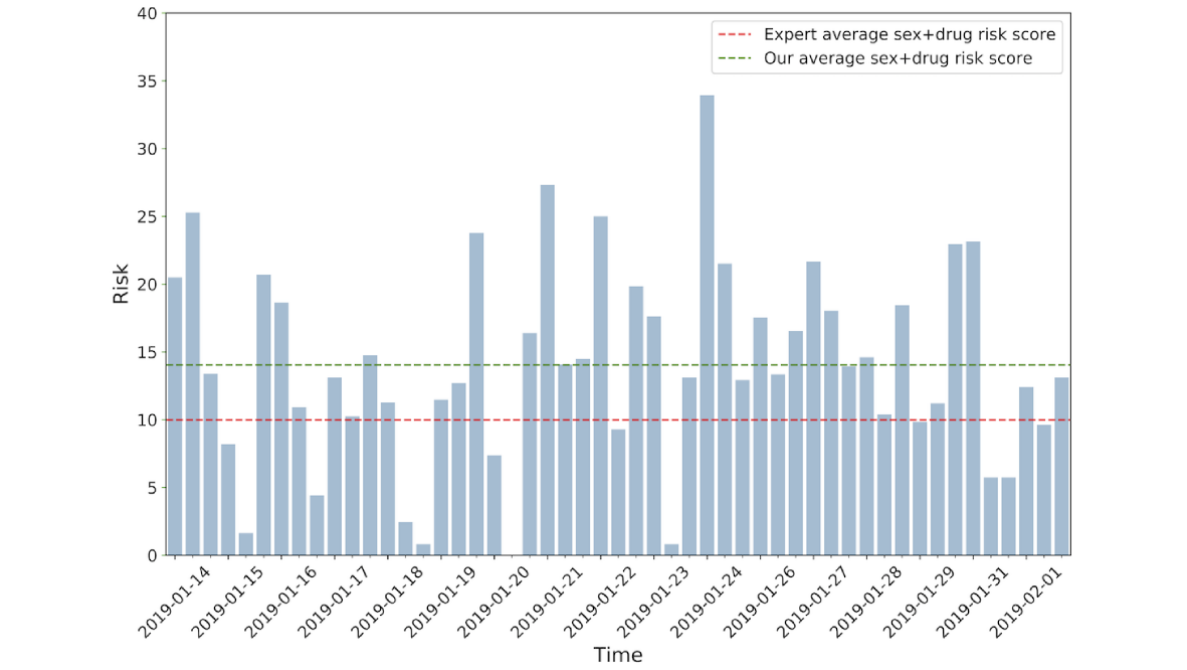
Figure 6. Normalized expert risk evaluation for drug and sex at 1 month and 3